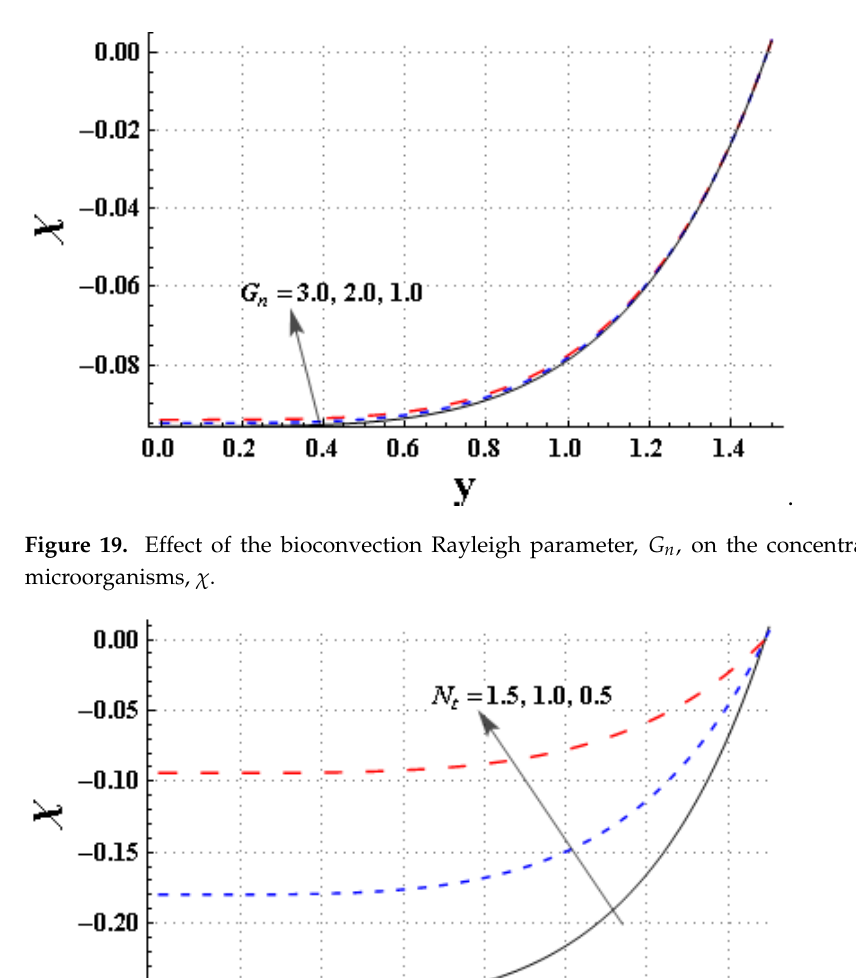
Figure 20. Effect of the thermophoresis number, N t , on the concentration of motile microorganisms, χ